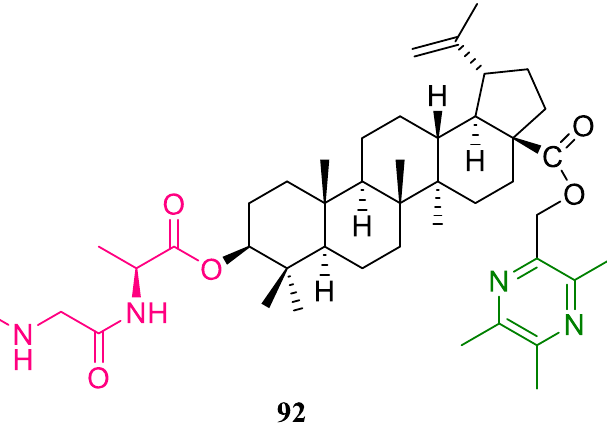
Figure 74. Peptide conjugates of pyrazine derivatives.